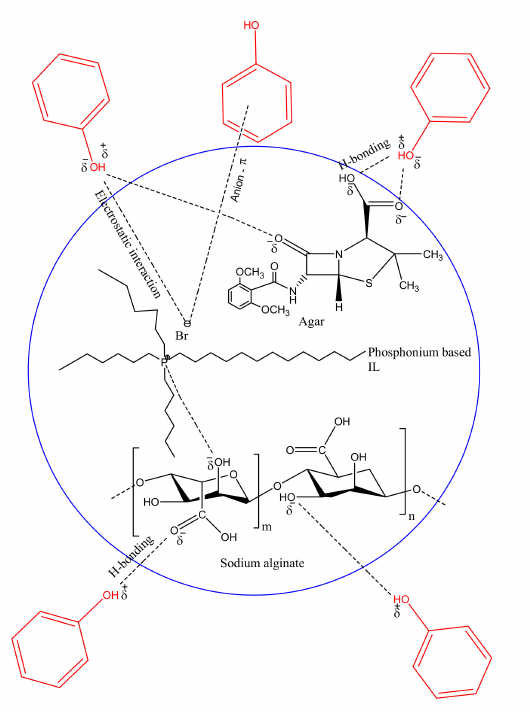
Figure 17. Proposed interaction forces between sodium alginate and IL and agar–IL–alginate beads with